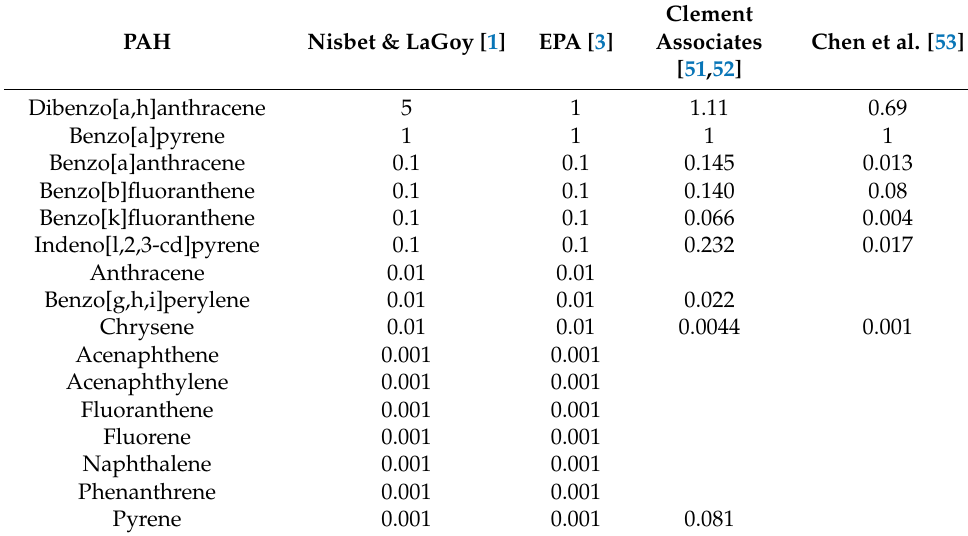
Table 1. The toxic equivalent factor (TEF) for individual PAHs.